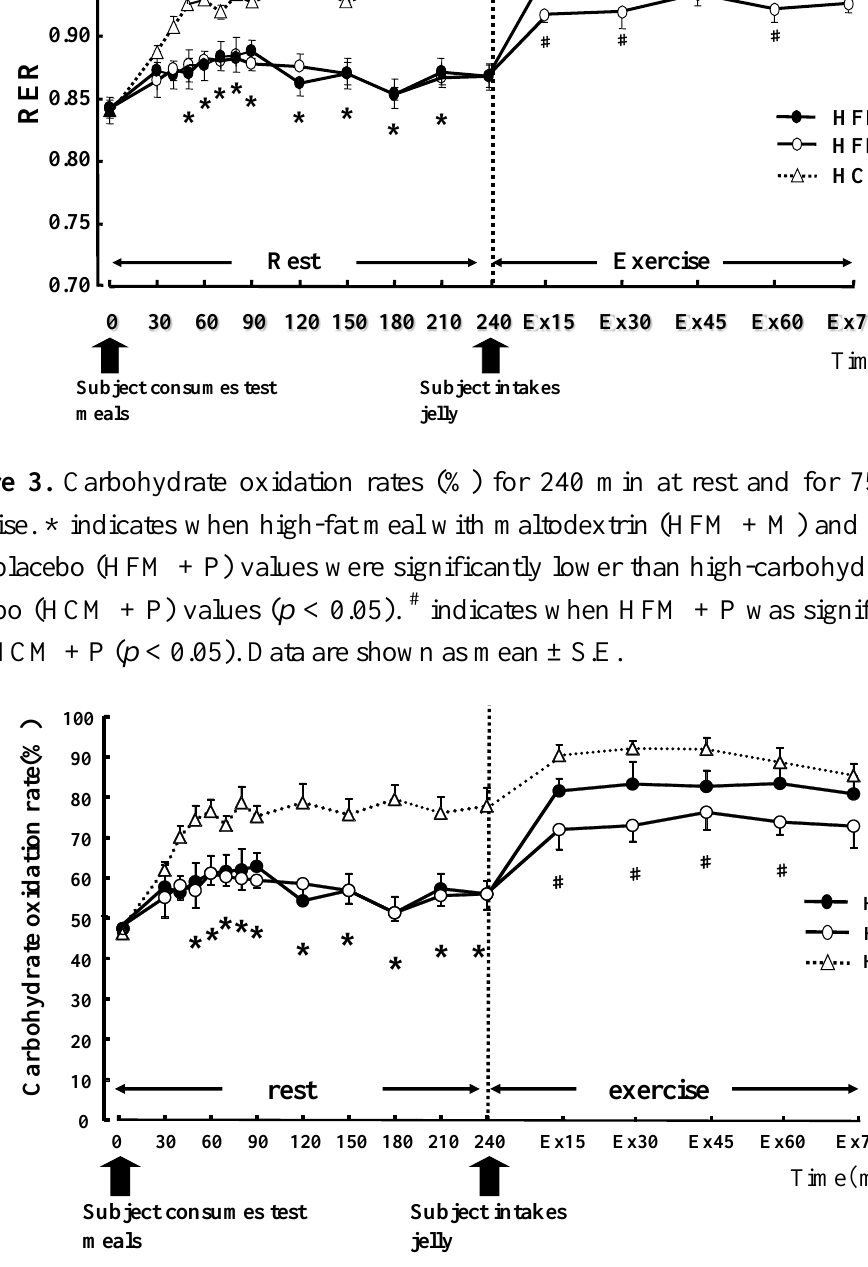
(0.28 ± 0.01 L/min, 0.27 ± 0.01 L/min, 0.27 ± 0.01 L/min, in HFM + M, HFM + P, and HCM + P, respectively) or during exercise (2.59 ± 0.16 L/min, 2.59 ± 0.14 L/min, 2.58 ± 0.17